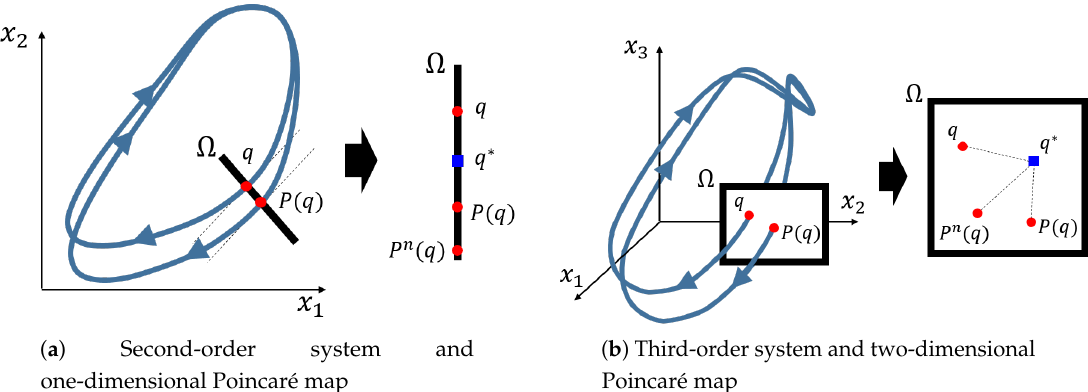
Figure 2. A conceptual sketch of Poincaré